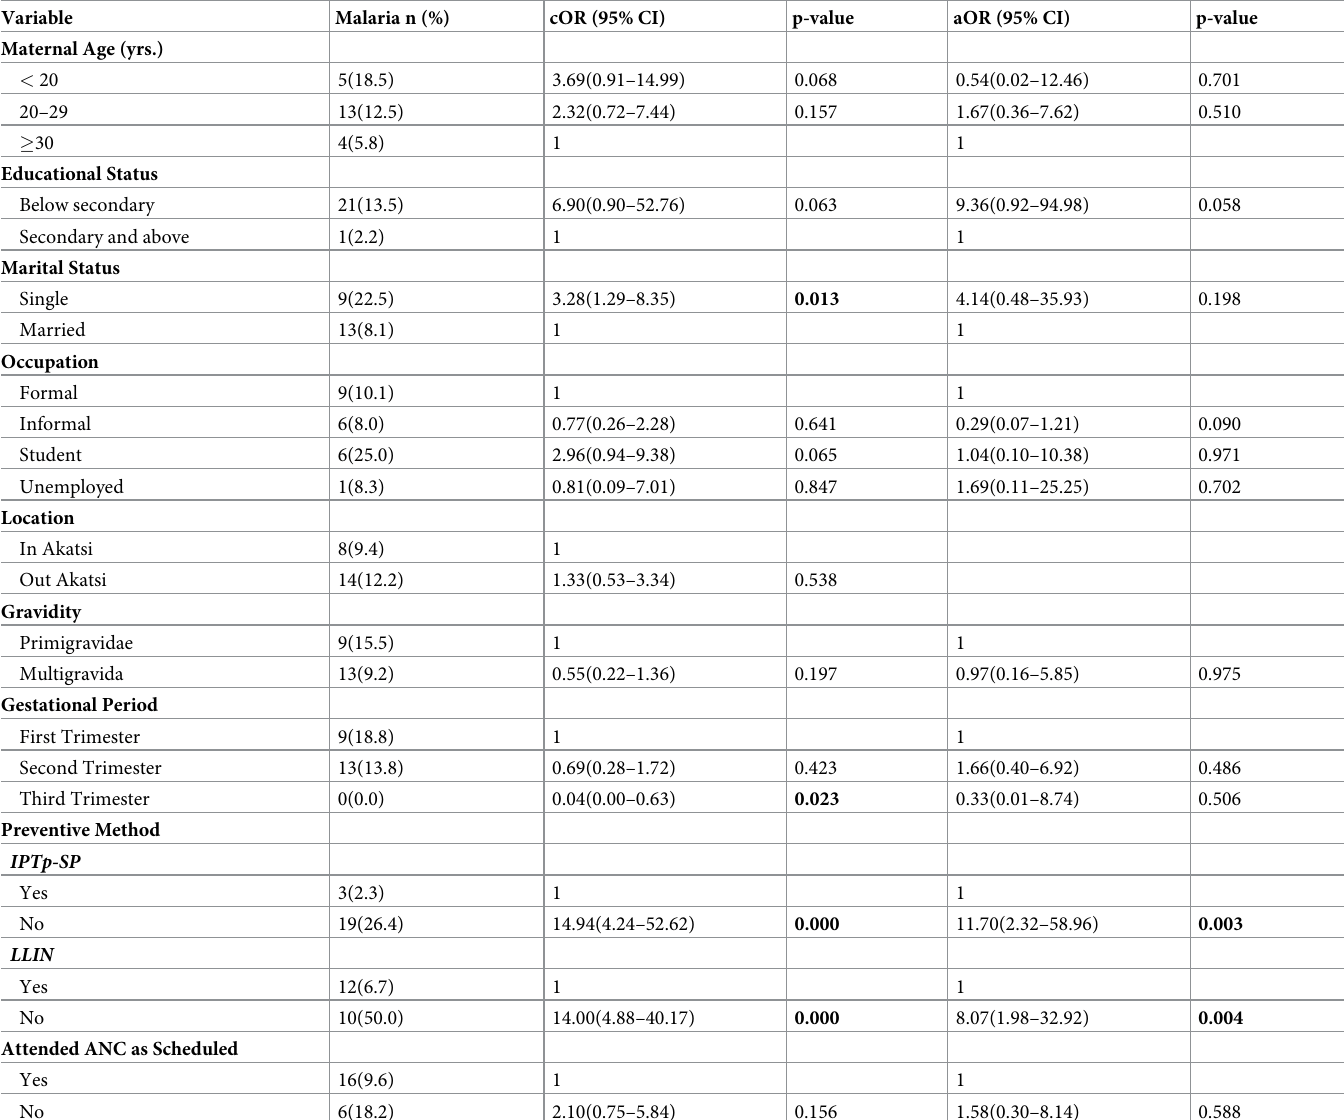
Table 4. Factors associated with malaria in pregnant women, Akatsi South District,